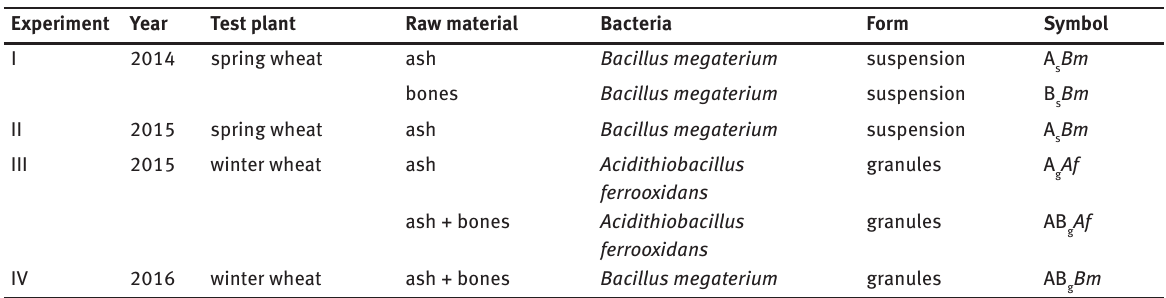
Table 1: Biofertilizers tested in the experiments. Experiment